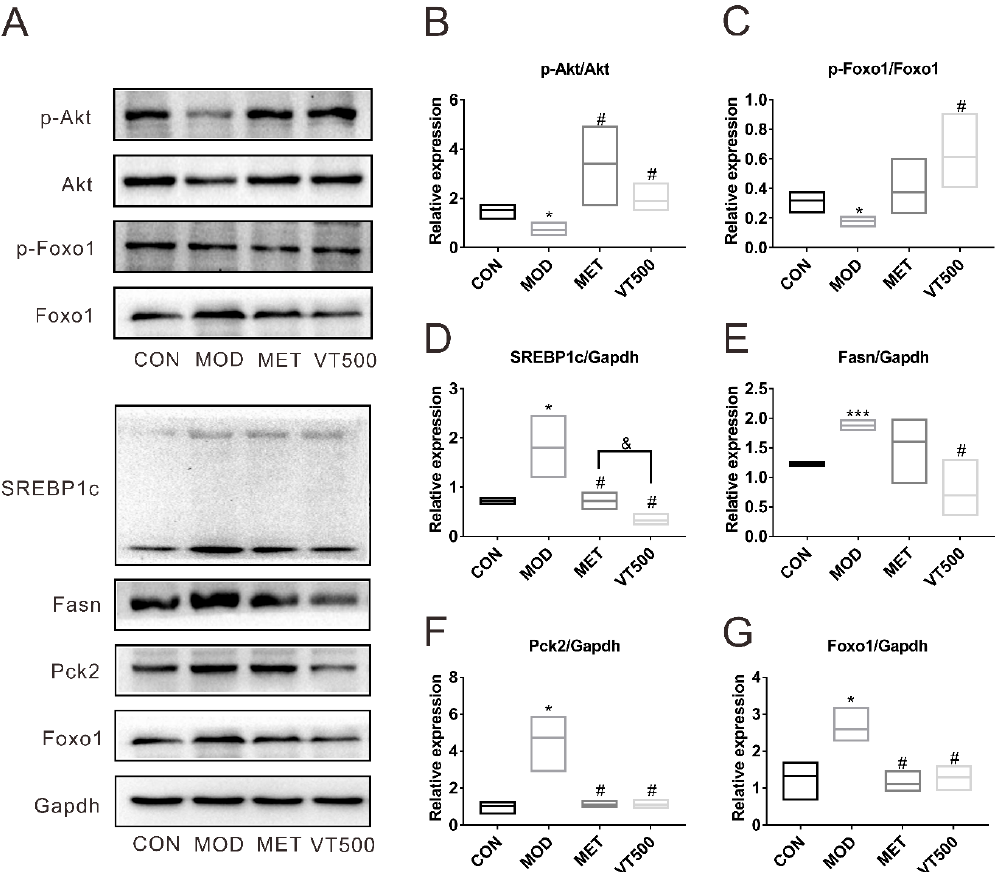
Figure 6. Effects of VT on the proteins involved in glucose and lipid metabolism. The expression of phosphorylated protein kinase B (p-Akt), Akt, phospho-Forkhead box protein O1 (p-Foxo1), Foxo1, sterol response element-binding protein 1c (SREBP1c), fatty acid synthase (Fasn), and phosphoenolpyruvate carboxykinase 2 (Pck2) was detected by WB, and Gapdh was simultaneously detected as a standard internal reference protein ( A ); the expression ratio of p-Akt to Akt in each group ( B ); the expression ratio of p-Foxo1 to Foxo1 in different group ( C ); the protein expression of SREBP1c in four groups ( D ); the protein expression of Fasn in each group ( E ); the protein expression of Pck2 in all groups ( F ); and the protein expression of Foxo1 in the respective groups ( G ). The data are presented as floating bars (min-max, three repetitions), and the CON group was used for standardization. * p < 0.05, *** p < 0.001 contrasted with the CON group, # p < 0.05 compared to the MOD group, and p < 0.05 compared with the MET group, n = 6.